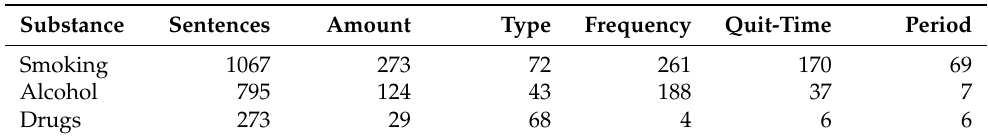
Table 4. Substance-use attribute annotation summary in terms of the number of sentences that contain relevant information.